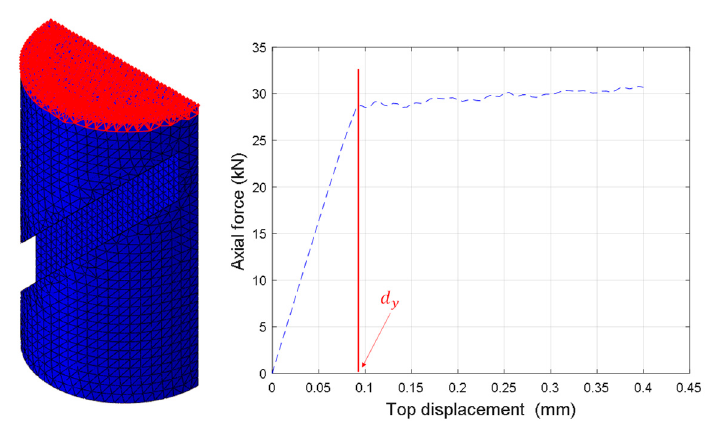
Figure A1. Identification of d y from the numerical F (element nodal extraction in red) versus d (unique nodal extraction) plot.